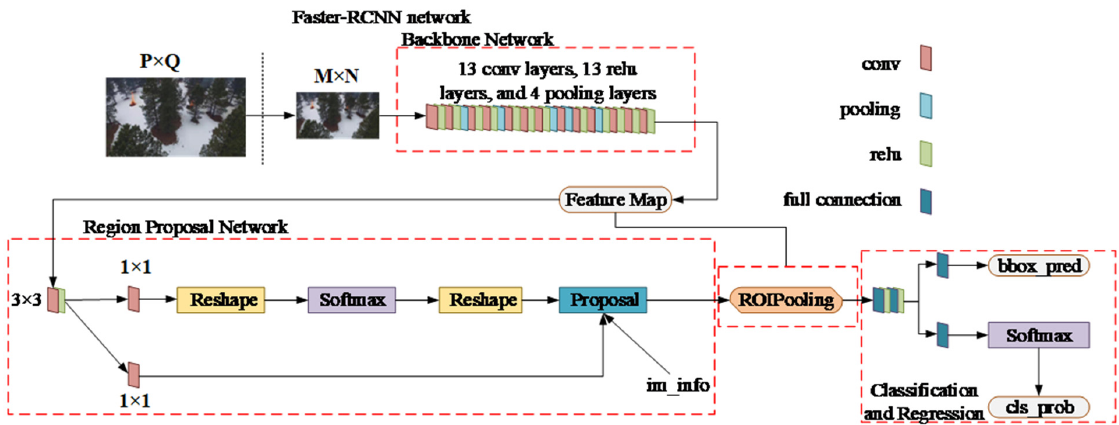
Figure 2. Faster RCNN network